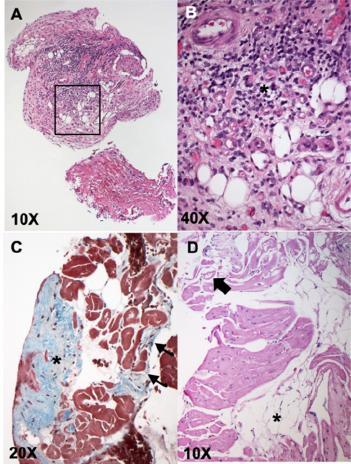
Figure 1. Representative histopathologic images from endomyocardial biopsies (EMBs) showing lymphoplasmacytic myocarditis ( A , B ), and arrhythmogenic right ventricular cardiomyopathy (ARVC) ( C , D ). Panels A (10×) and B (40×—from black box inset in ( A )): H&E stained sample diag- nostic for lymphoplasmacytic myocarditis (dog #29). These images show an endocardial lining with marked fibrotic thickening and massive lymphoplasmacellular infiltrate (purple infiltrate, asterisk, panel ( B )); associated with fibrosis with neovascularization (vascular granulation tissue). Panel ( C ): Masson’s trichrome stain revealing focal subendocardial fibrosis (asterisk) and multifocal interstitial fibrosis (arrows). Panel ( D ) shows H&E stain revealing multifocal groups of adipocytes (asterisks) as- sociated with fibrosis and rarefaction and vacuolization of the cardiomyocytes (arrow). The findings in Panels ( C , D ) contributed to the diagnosis of ARVC in dog